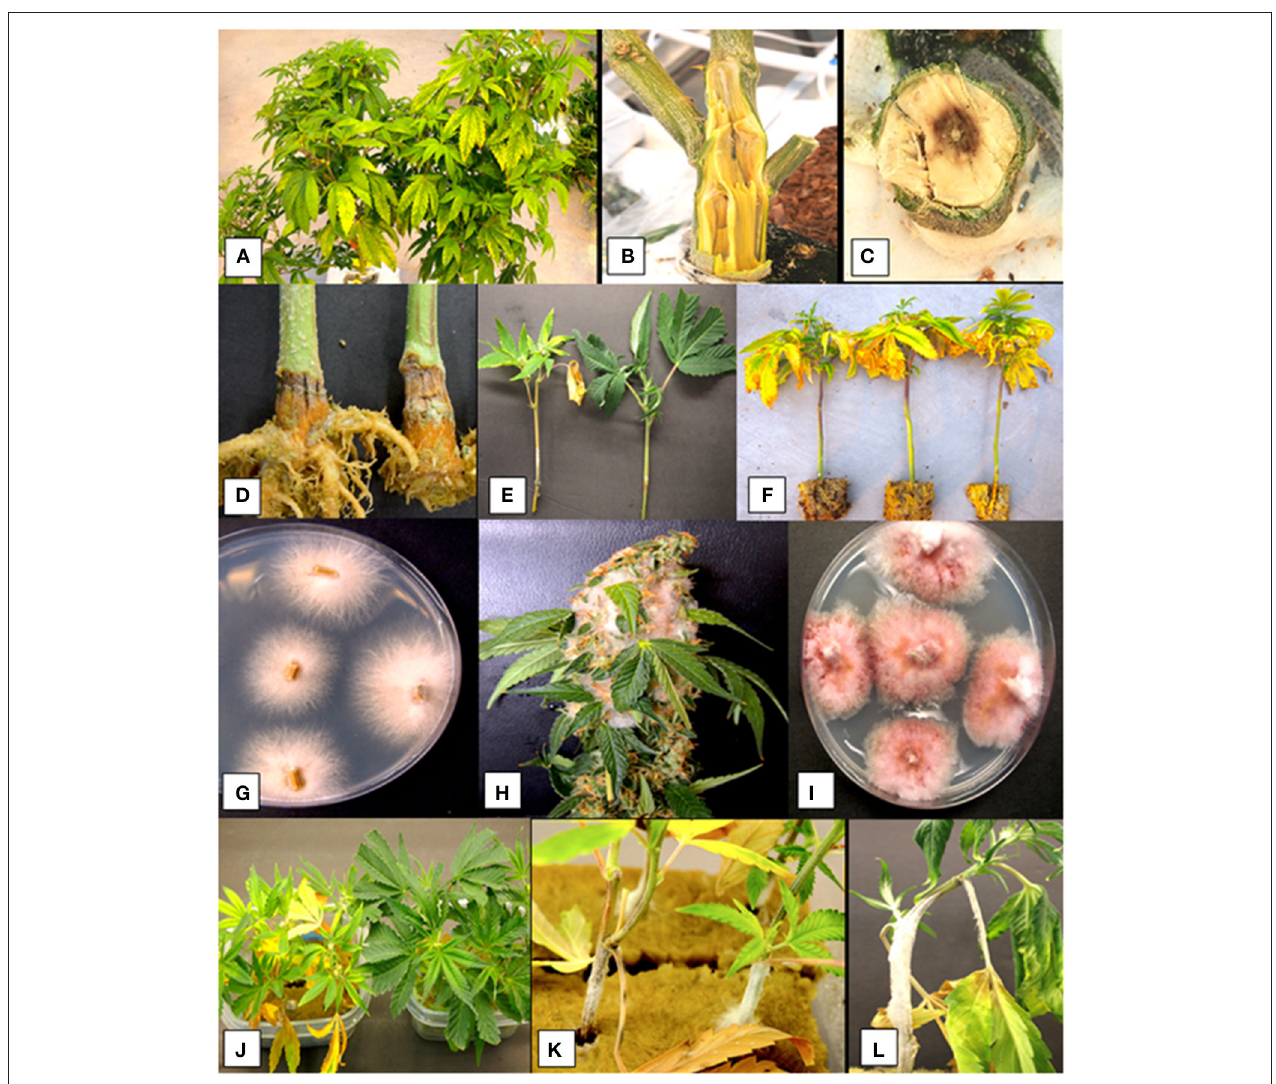
FIGURE 4 | Infection of greenhouse grown cannabis plants by Fusarium species. (A) Yellowing symptoms on stock plants. (B) Crown infection and decay caused by F. solani . (C) Pith necrosis caused by F. proliferatum . (D) Crown rot caused by F. oxysporum. (E) Diseased cutting (left) compared to healthy one (right) caused by F . oxysporum . (F) Symptoms of yellowing on rooted cuttings caused by F. oxysporum . (G) Colonies of F. oxysporum recovered from symptomatic tissues. (H) Flower infection caused by F. sporotrichiodes . (I) Recovery of colonies of F. sporotrichiodes from diseased flower. (J–L) Pathogenicity tests with F. oxysporum on cannabis cuttings showing development of symptoms of yellowing and mycelial growth. Photographs courtesy of Zamir Punja.